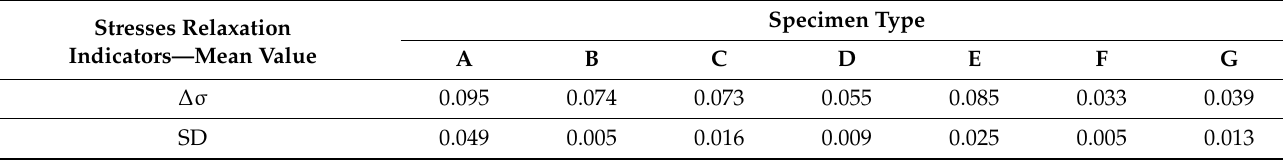
Table 4. Stress relaxation indices for all